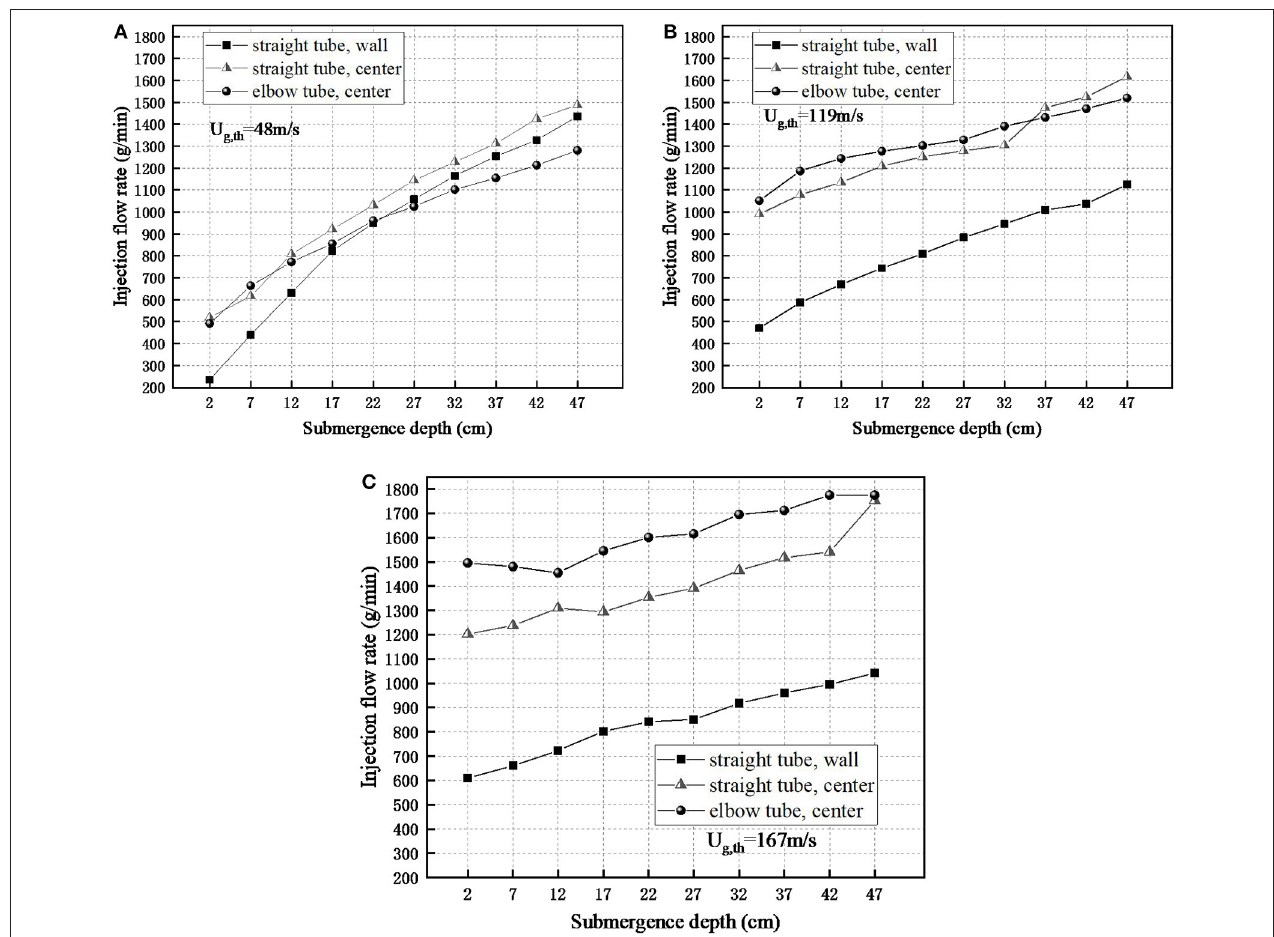
FIGURE 6 | Influence of different submergence depth on injection flow rate. (A) U g,th = 48 m/s, (B) U g,th = 119 m/s, (C) U g,th = 167